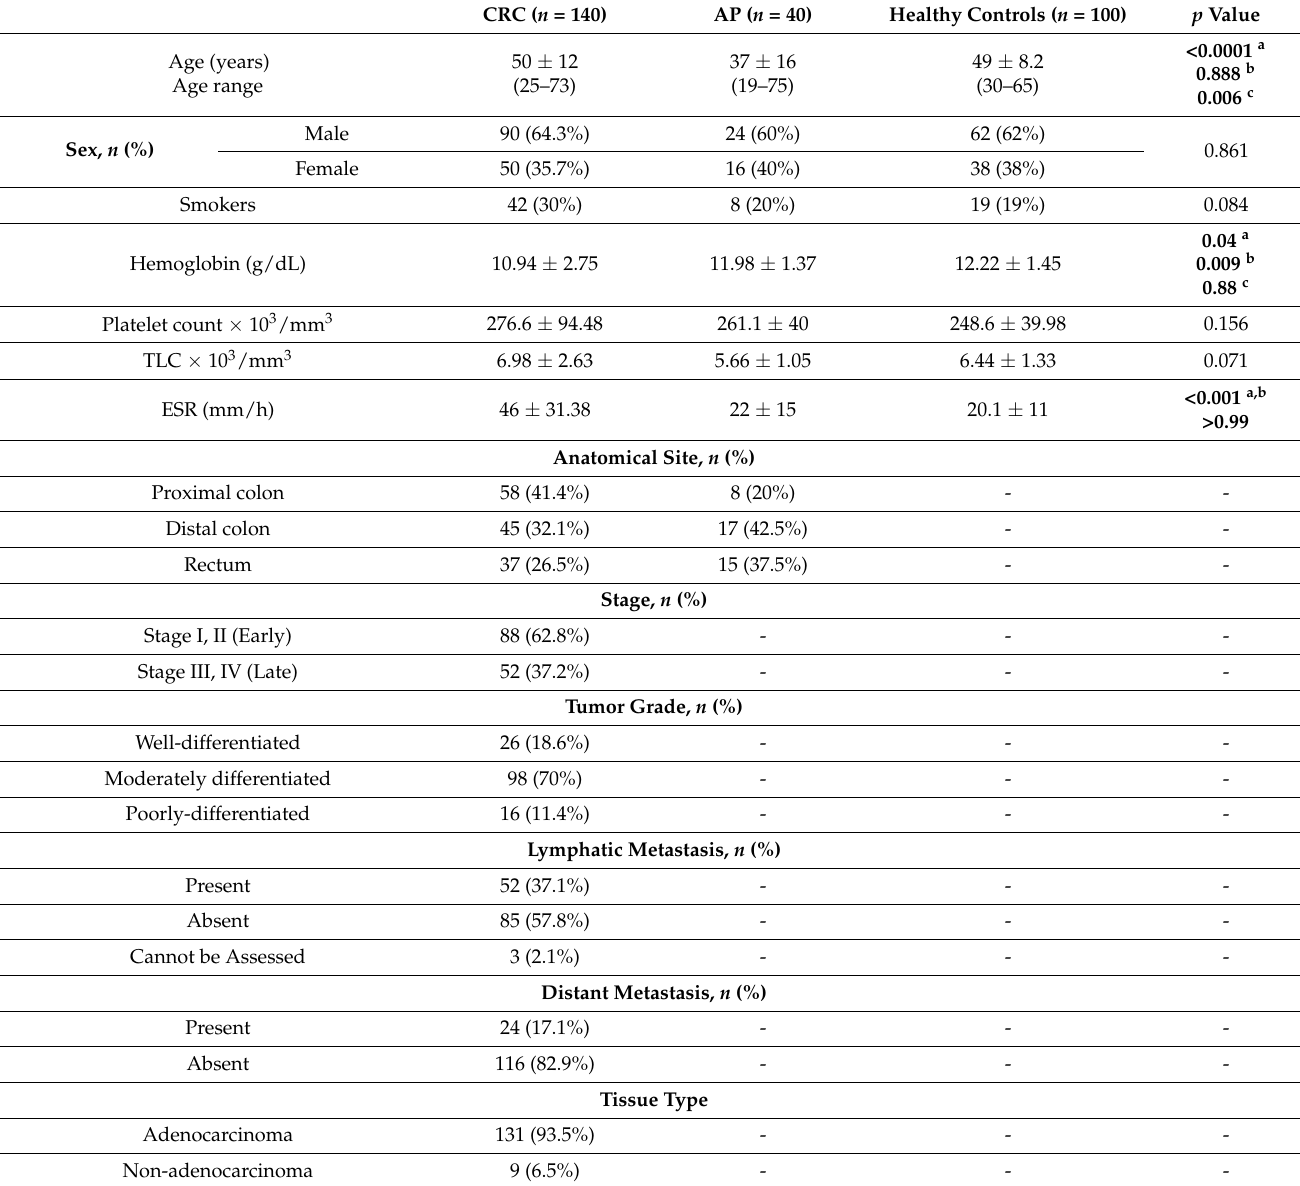
Table 1. Values of the demographic and clinicopathological data of the studied